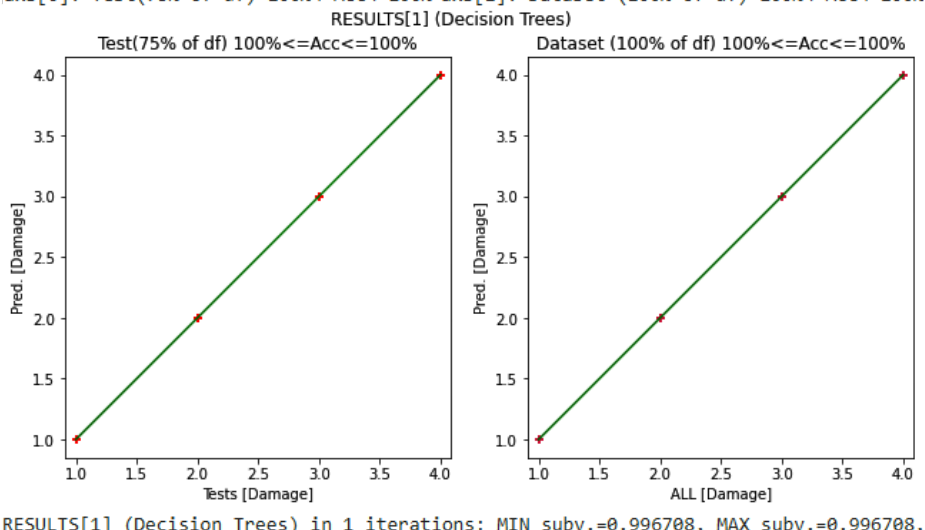
Figure 7. Relationship of the predicted [ Damage ] with the tested [ Damage ] and all [ Damage ].